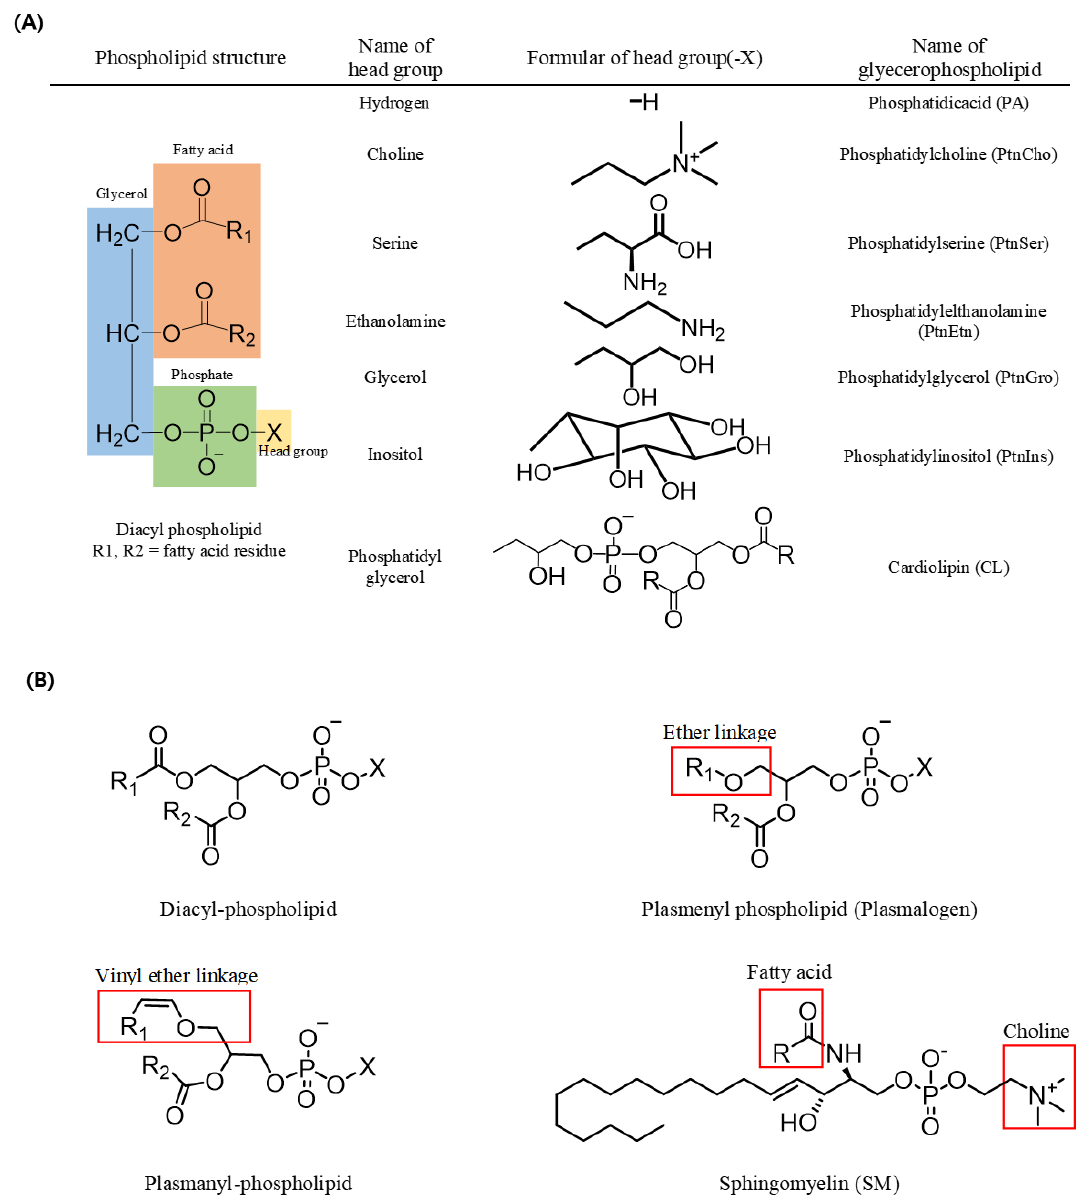
Figure 1. Structures of phospholipids. ( A ) Name of the phospholipid according to the change of